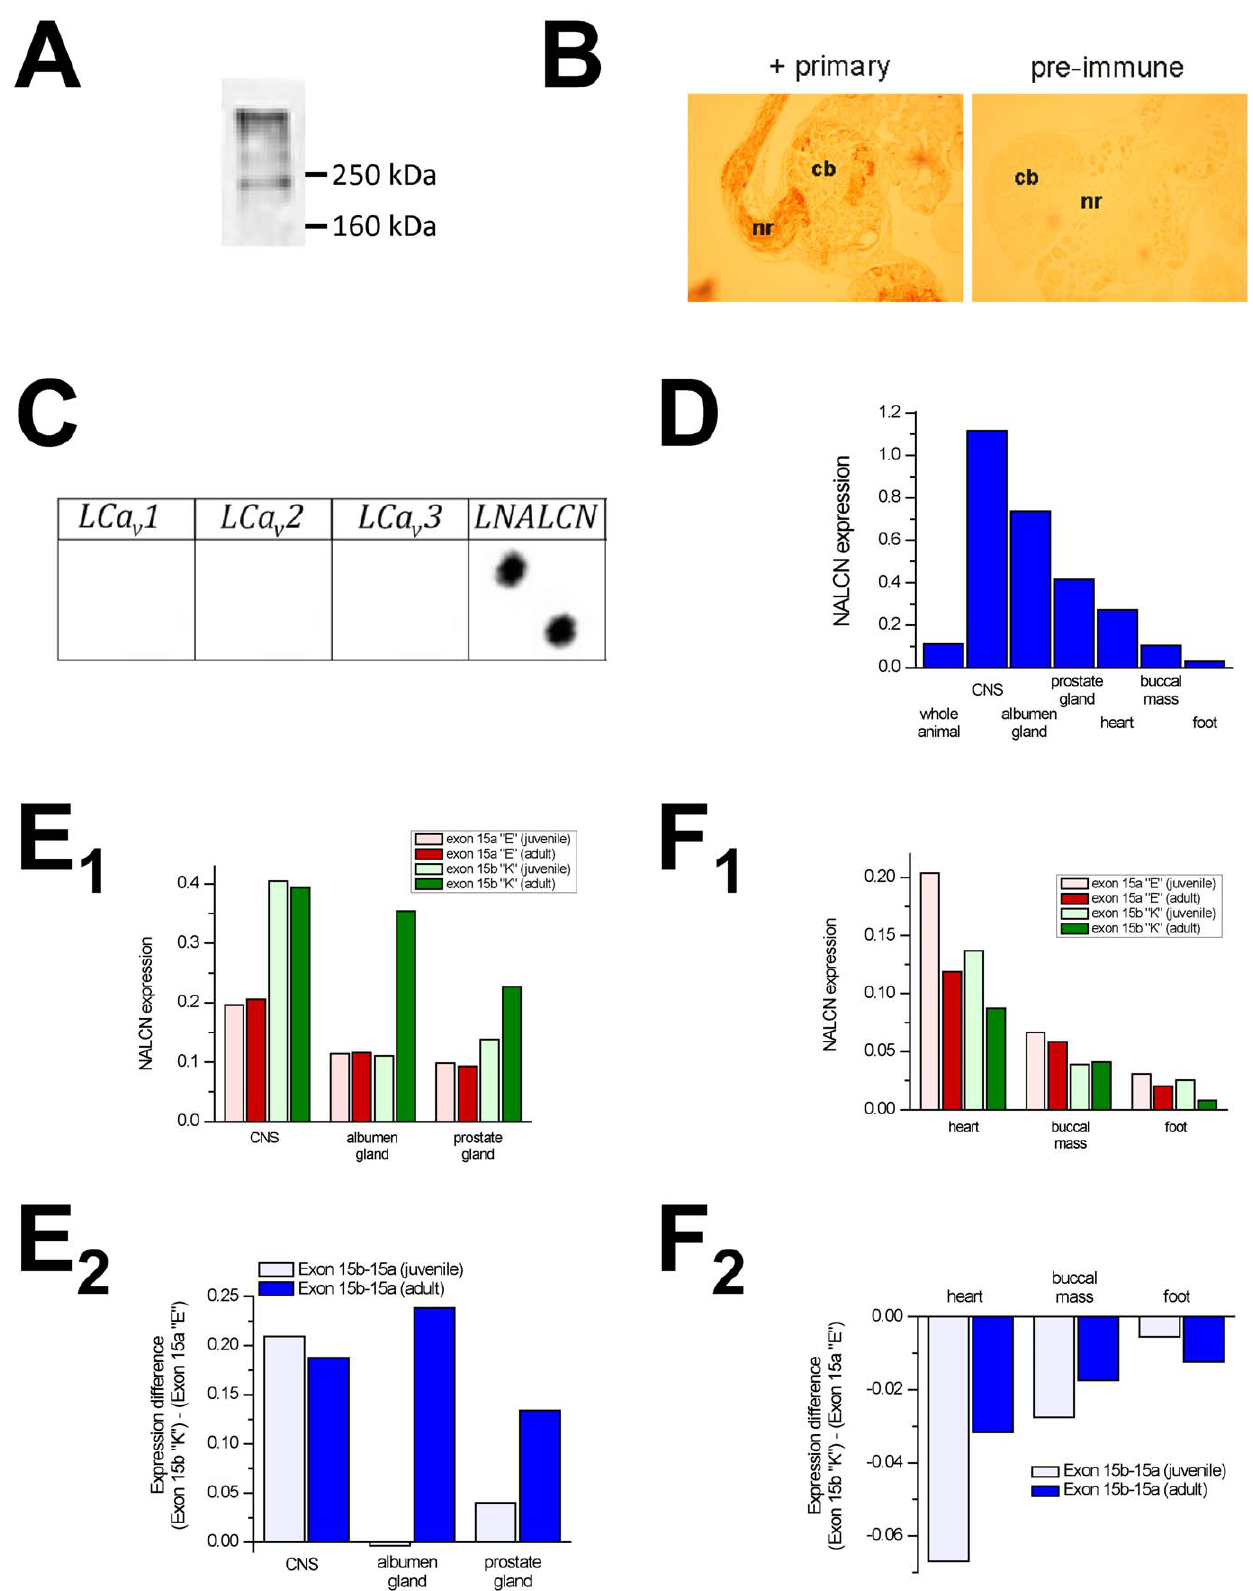
Figure 5. NALCN mRNA expression in Lymnaea pond snail measured by quantitative PCR reveals unique expression profiles of sodium-selective pore (EKEE) and calcium-selective pore (EEEE) variants. (A) Lymnaea NALCN antibody identifies appropriately-sized , 200 kDa NALCN protein in Lymnaea brain homogenate of a Western blot. (B) Antibody staining of Lymnaea brain using polyclonal antibodies